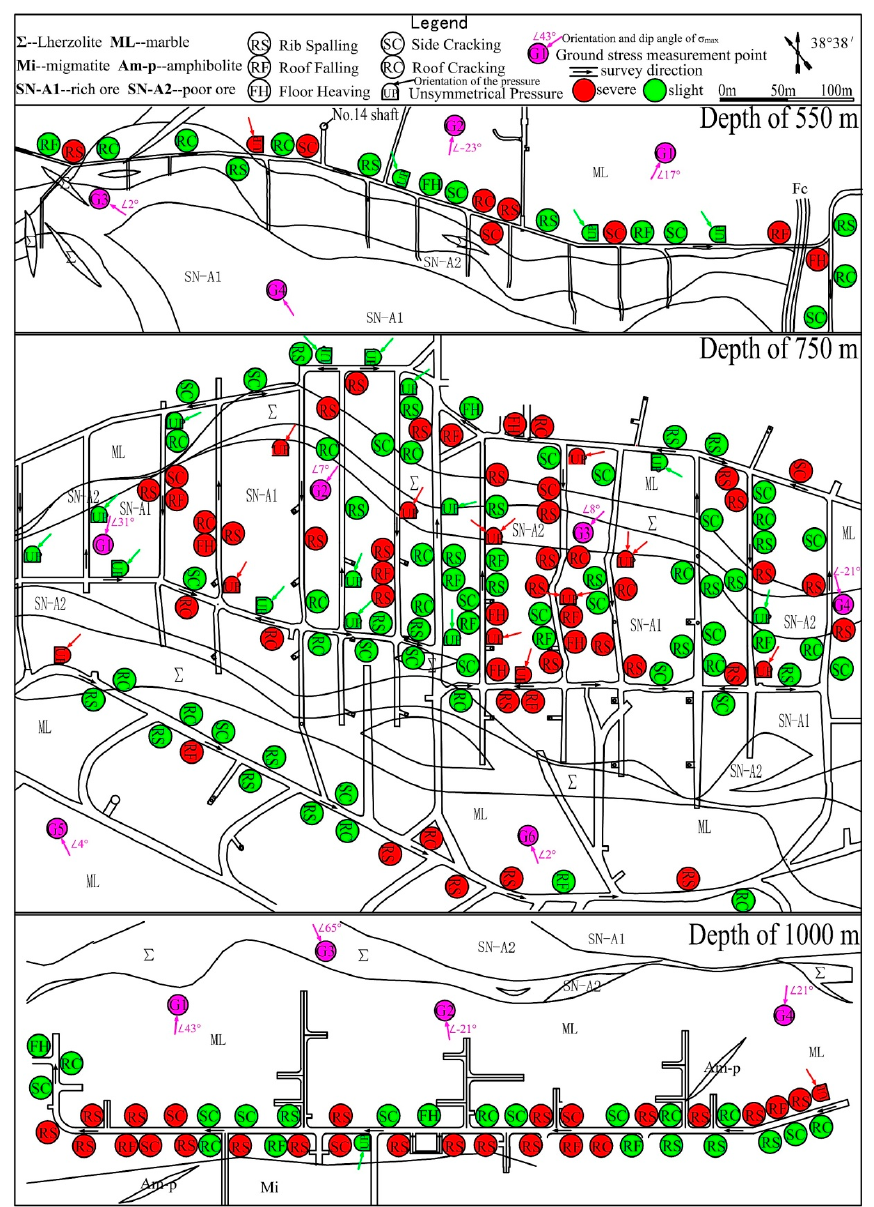
Figure 2. Field investigation results [21,22].